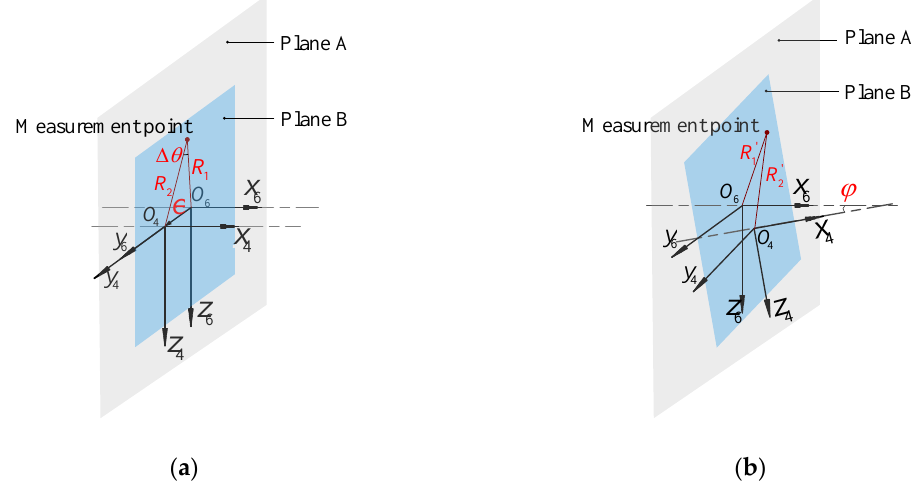
Figure 3. ( a ) Angle measurement relationship only considering eccentricity. ( b ) Angle measurement relationship considering geometric